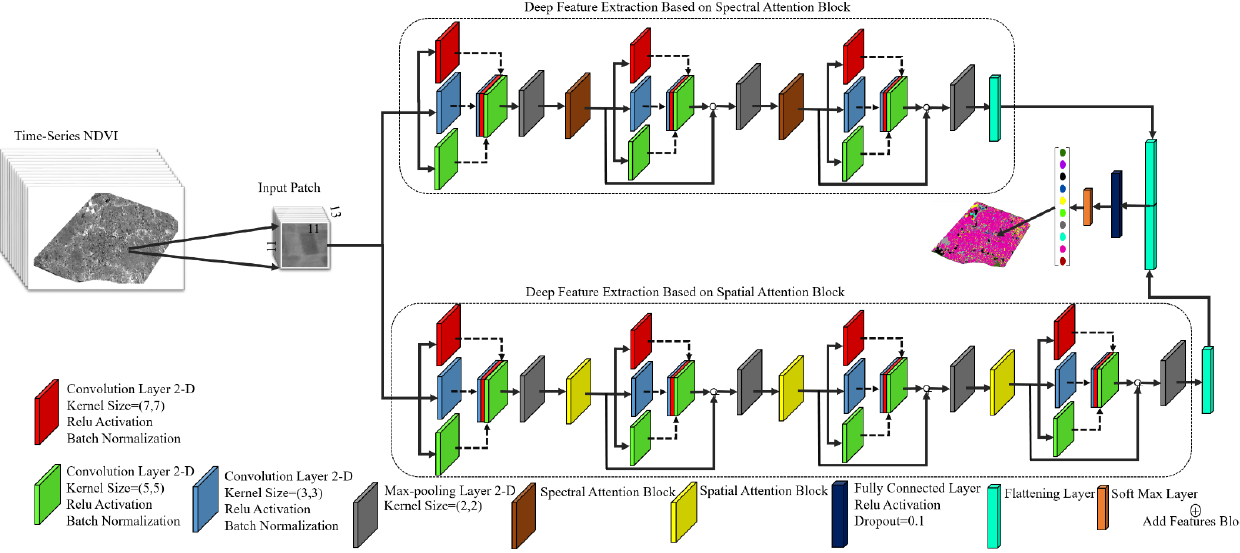
Figure 4. The proposed dual-stream spatial and spectral attention blocks framework for crop map- ping.